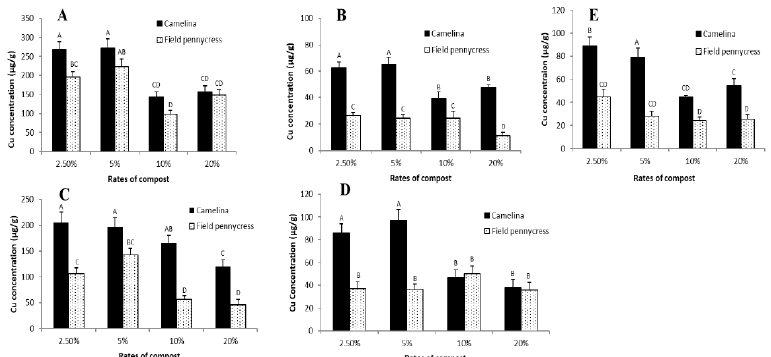
Figure 1. Total Cu (mg/kg) in roots ( A ), stem ( B ), leaves ( C ), pods ( D ), and seeds ( E ) of camelina and field pennycress as affected by different rates of compost during the study period. Data are reported as mean ± S.D ( n = 3). Means are compared by Tukey Kramer-HSD test ( α = 0.05). The treatment levels that are not connected by the same letter are significantly different from each other.